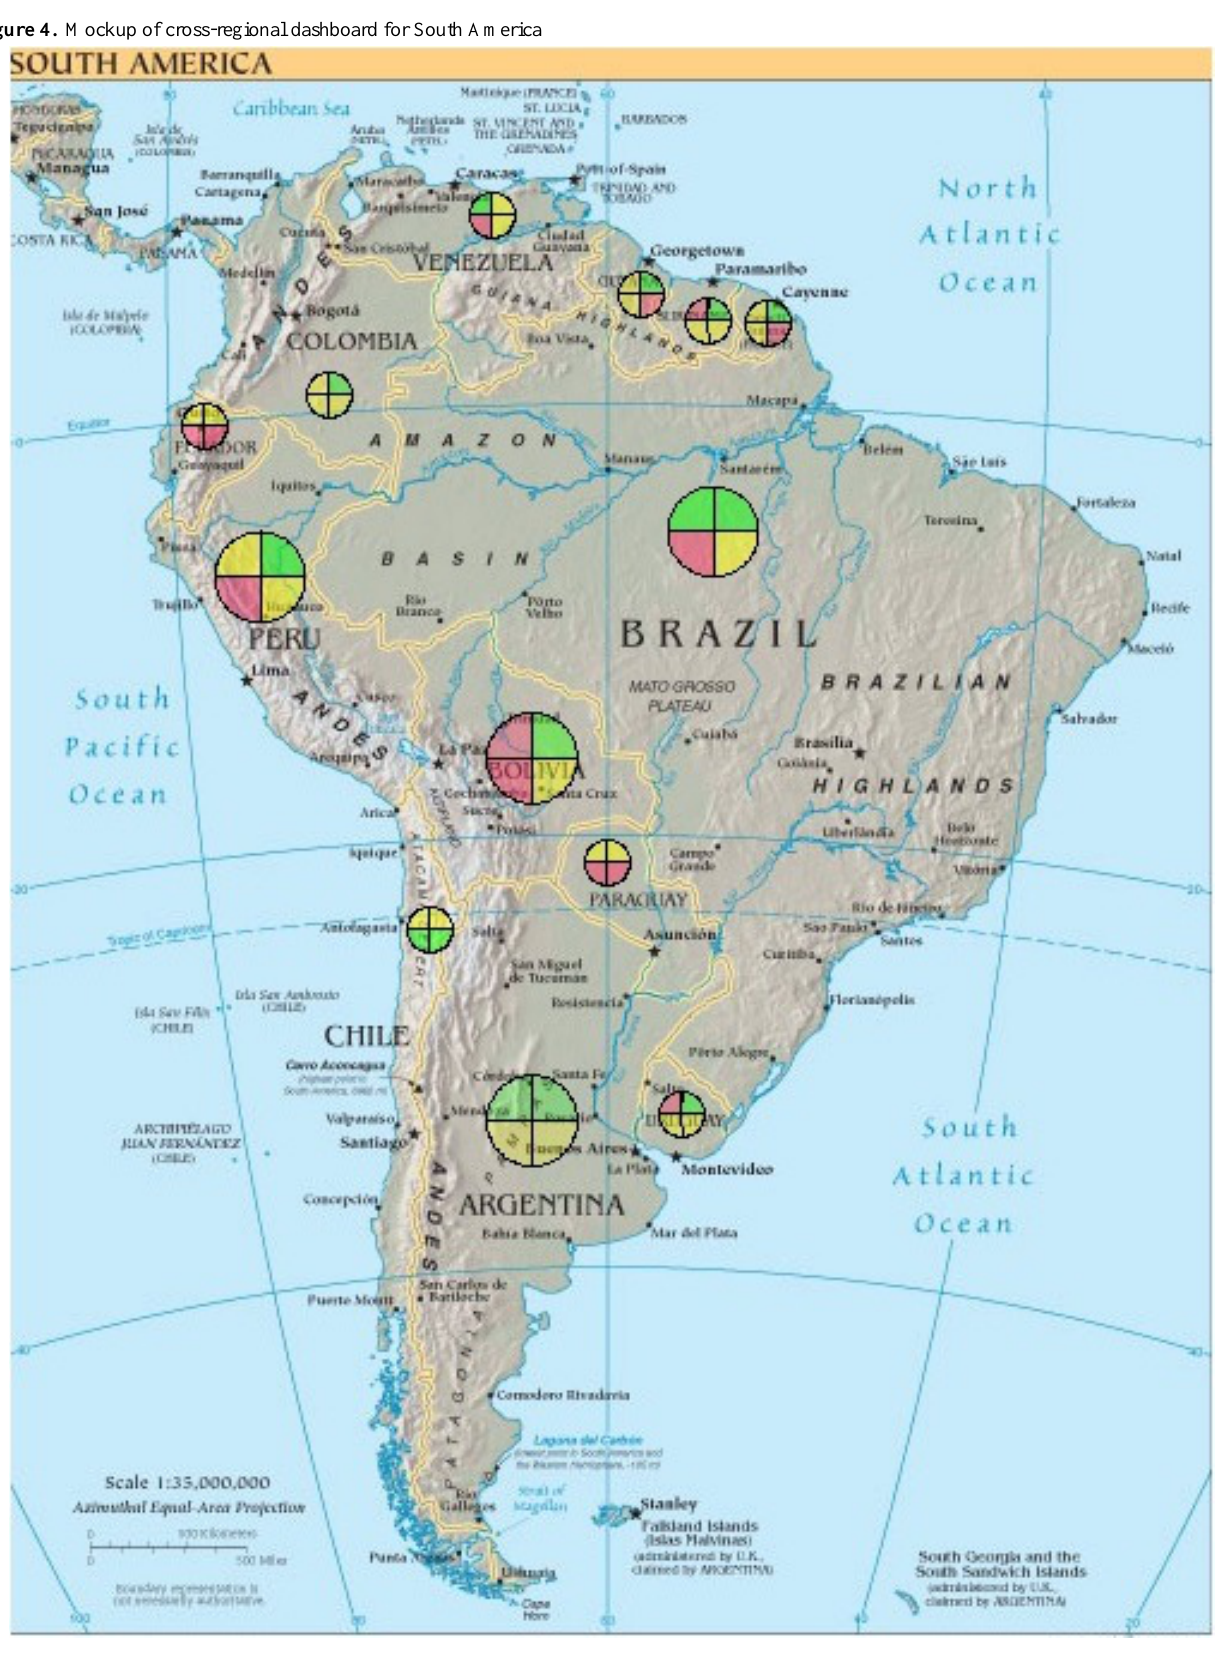
Figure 4. Mockup of cross-regional dashboard for South